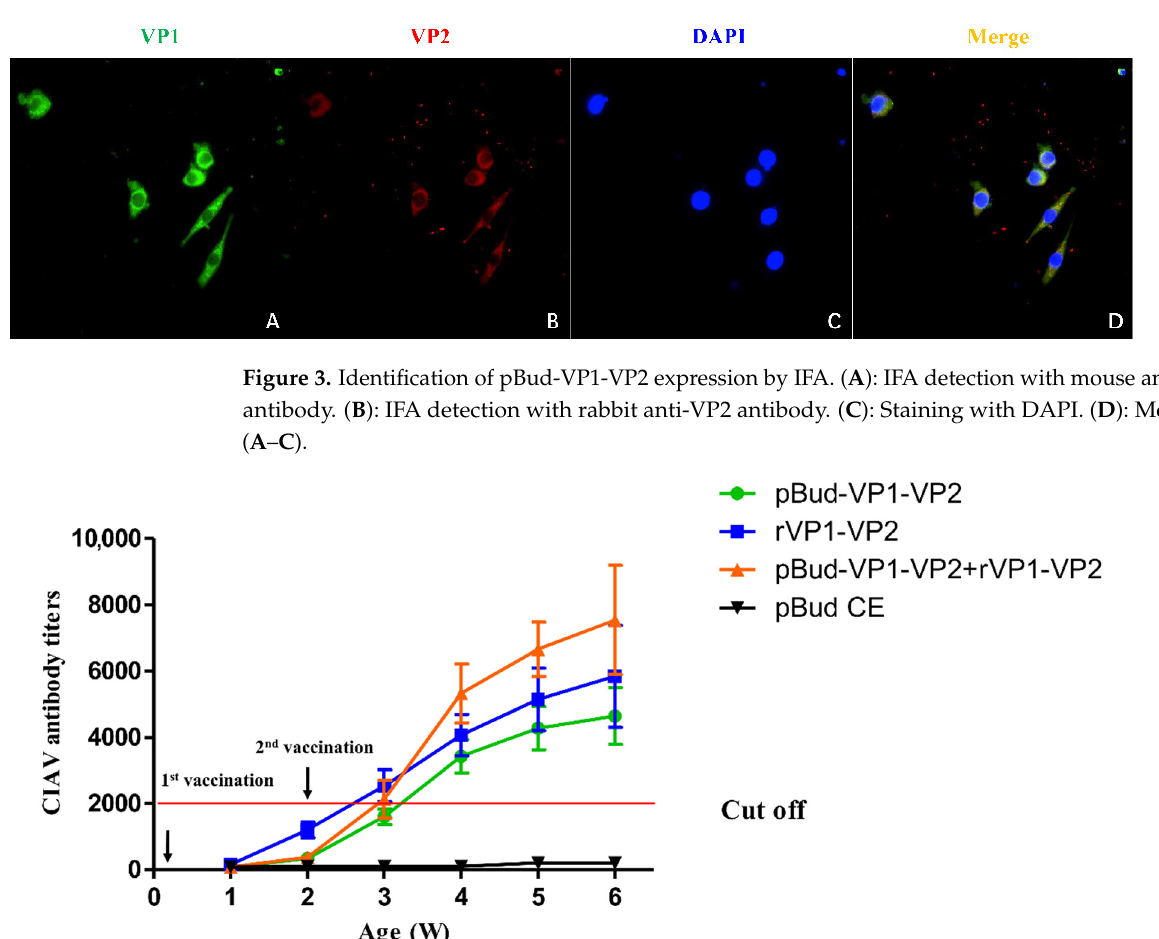
Figure 4. Antibody titer determination after vaccination.